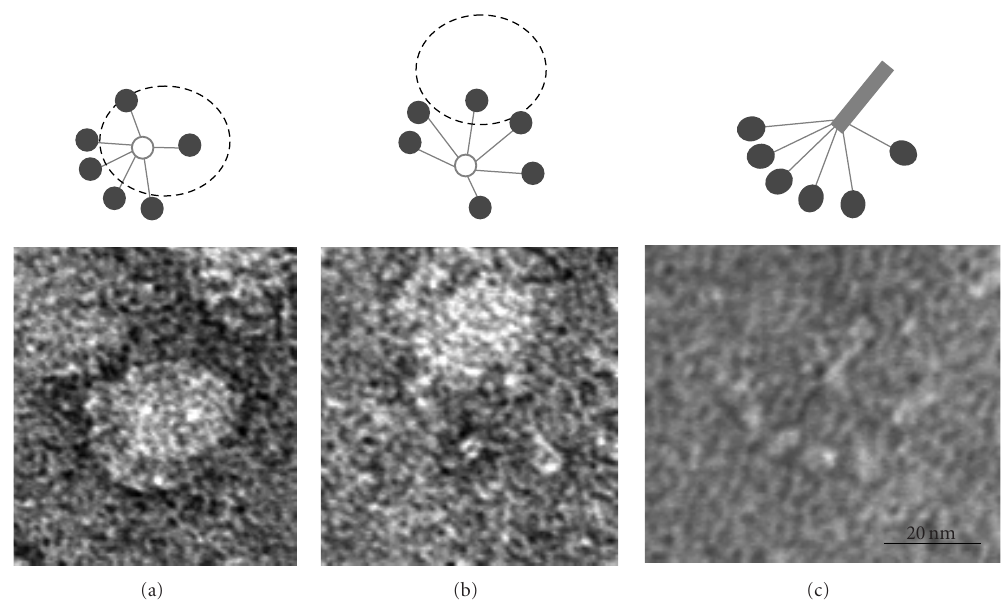
Figure 4: Electron micrographs of E-LDL-bound C1q molecules. (a, b) Examples of C1q molecules interacting through most of their globular domains (a) or only a few (b). (c) Representative example of a free C1q molecule (modified from [15], with